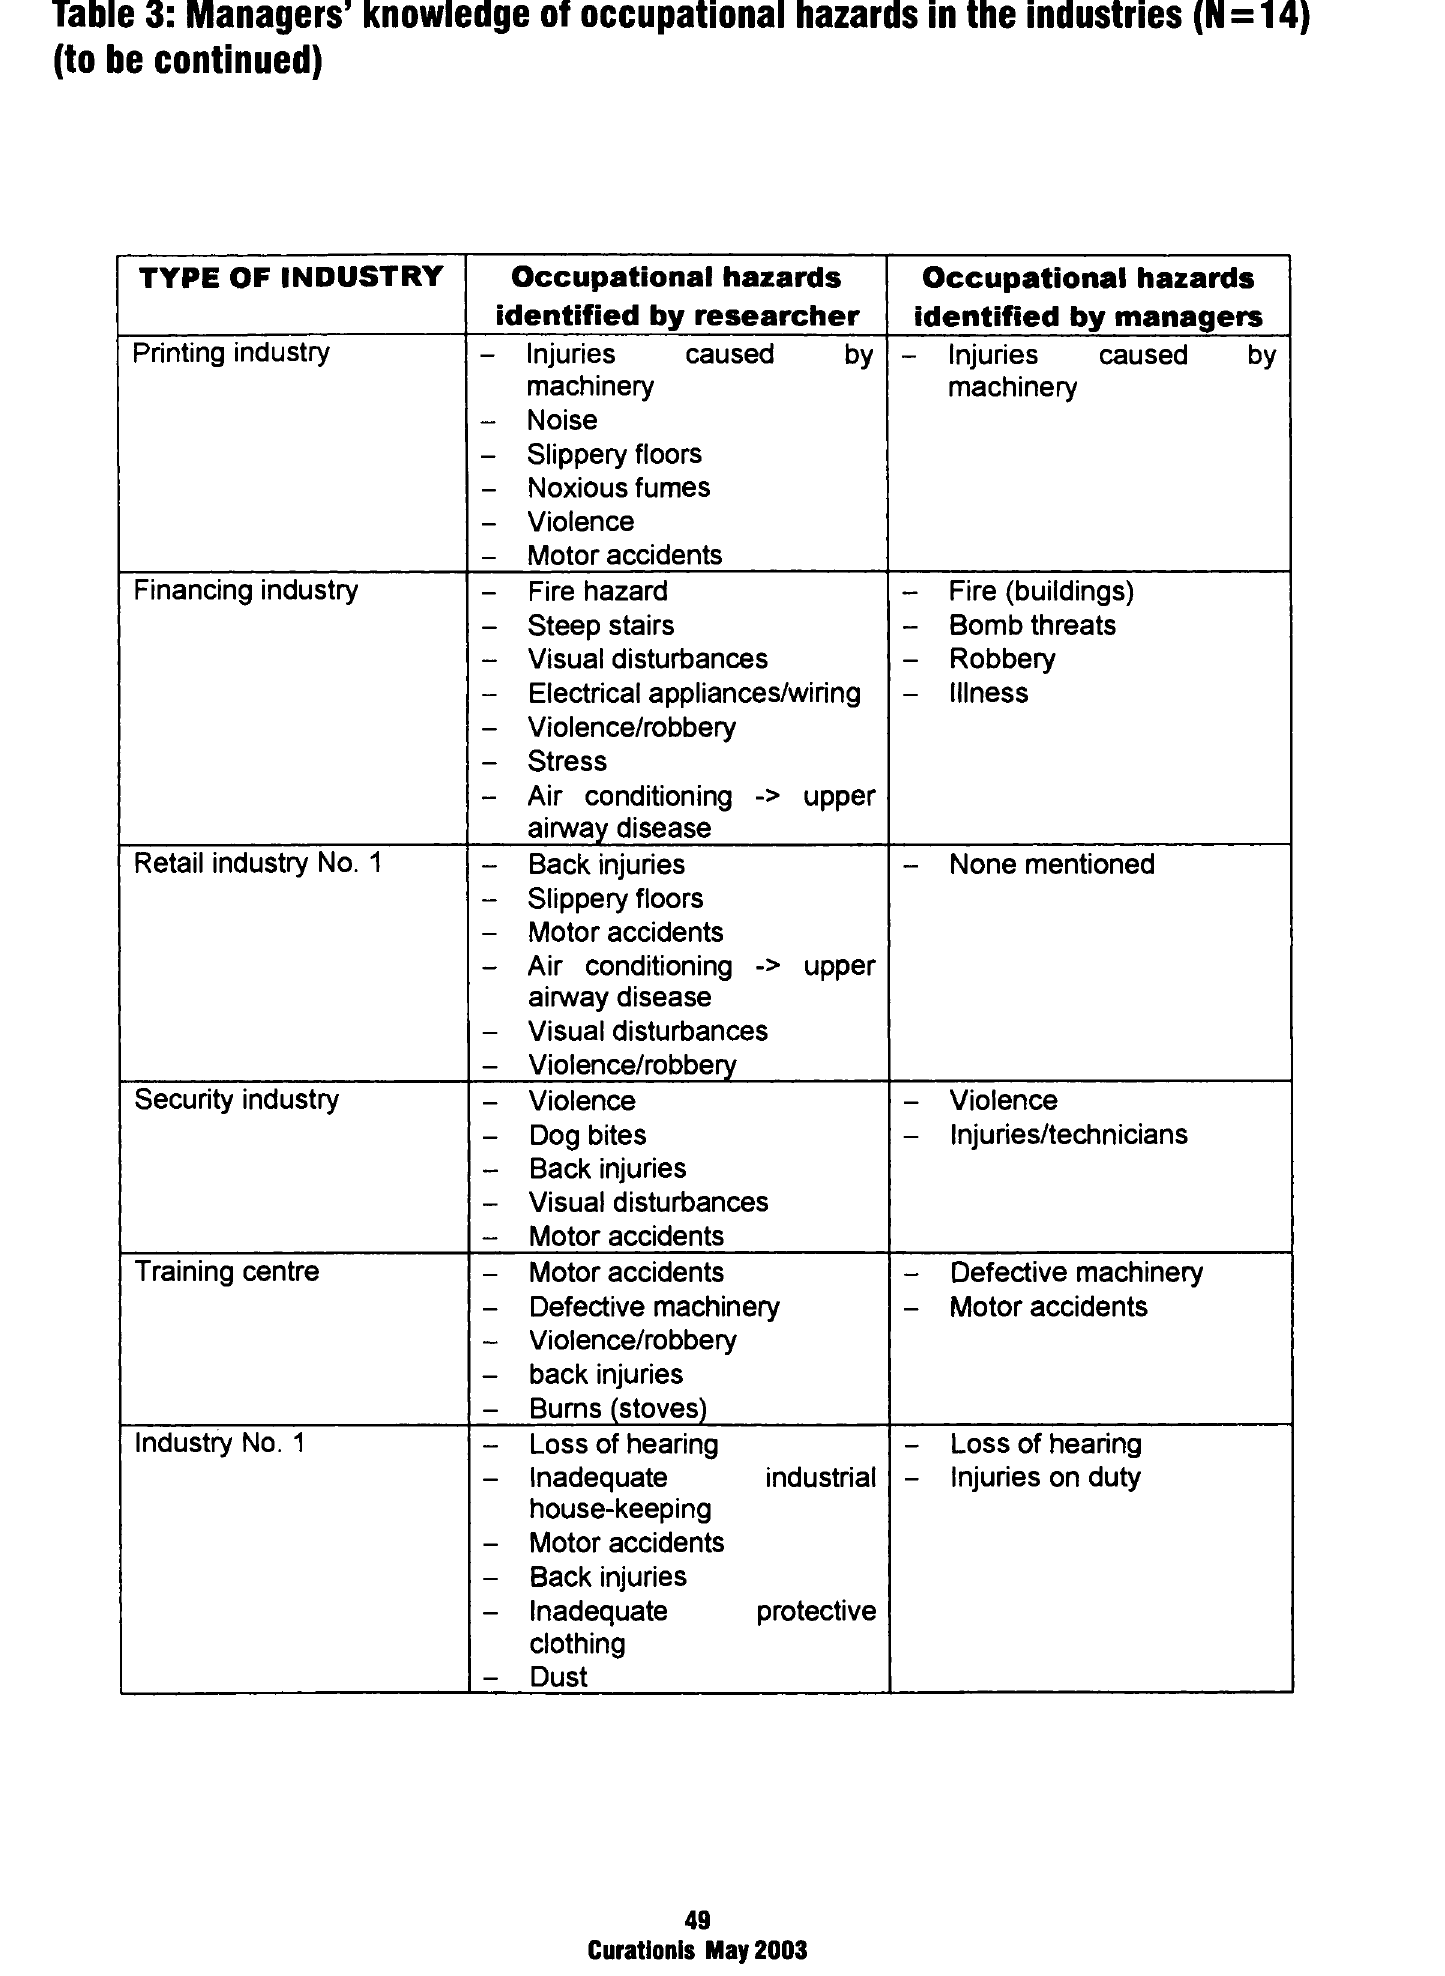
Table 3: Managers’ knowledge of occupational hazards in the industries (N=14) (to be